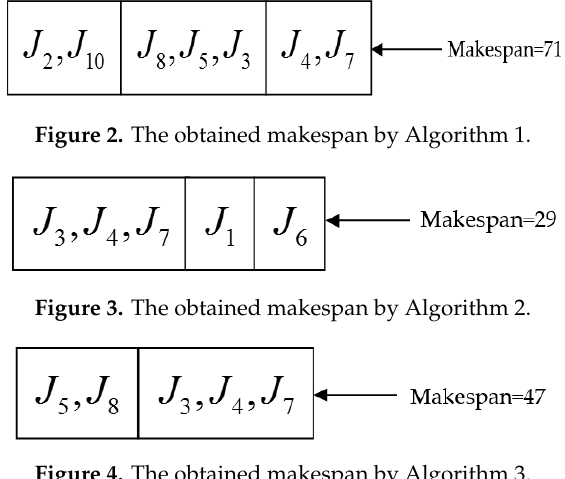
Figure 4. The obtained makespan by Algorithm 3.